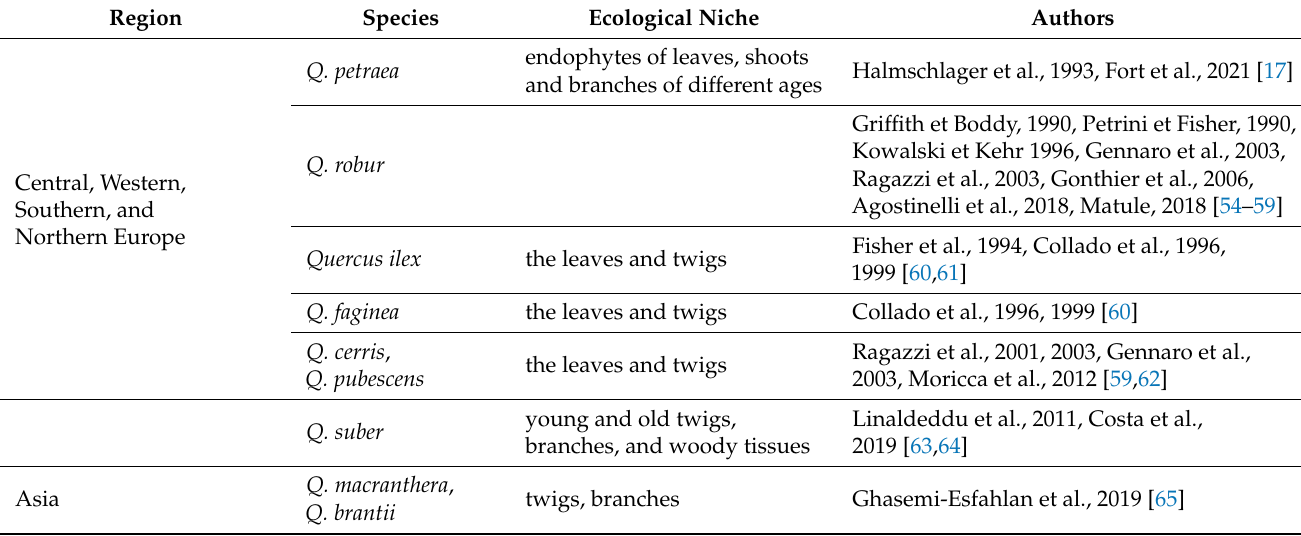
Table 1. Study of the endophytic mycobiota of Quercus